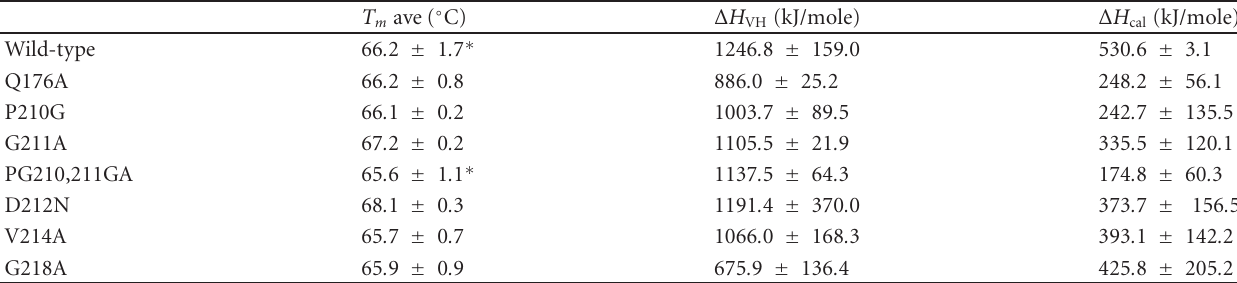
Table 1: DSC analyses of wild-type and mutant